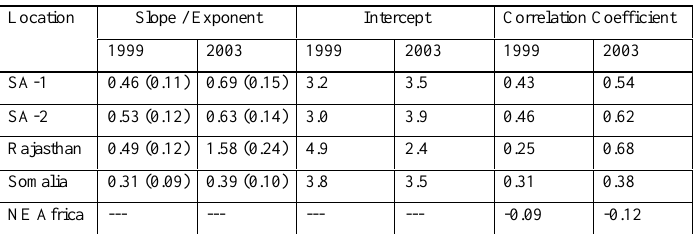
Table 2. Regression parameters of wind dependence. Table-2. Regression Parameters of Wind